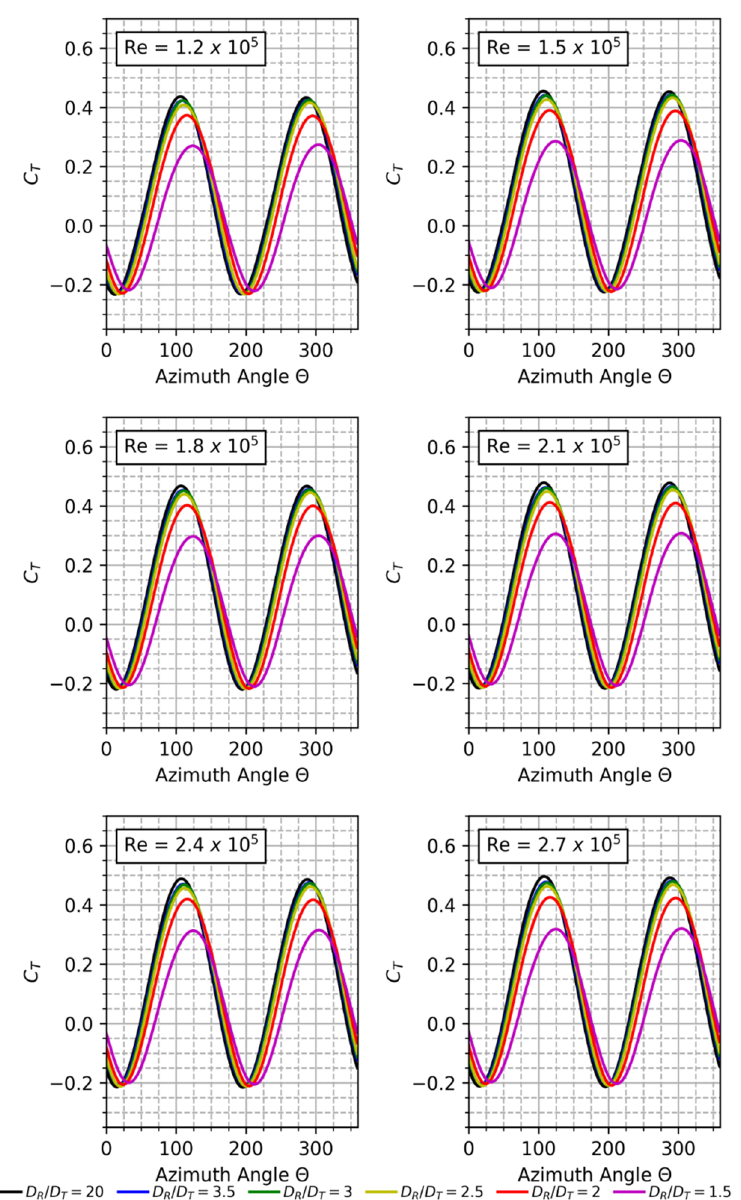
Figure 6. Effect of Re on Torque Coefficient. Figure 6. E ff ect of Re on Torque Coe ffi